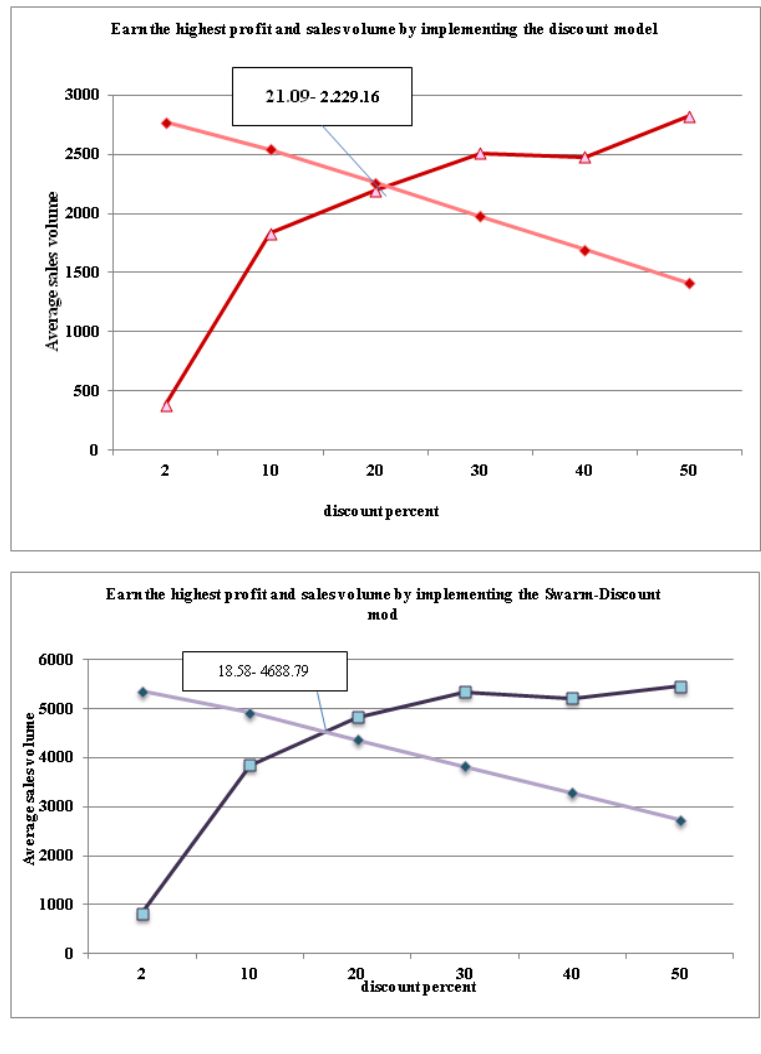
Fig. 12. Simulating customers' IB behavior and optimal discount point for highest revenue and